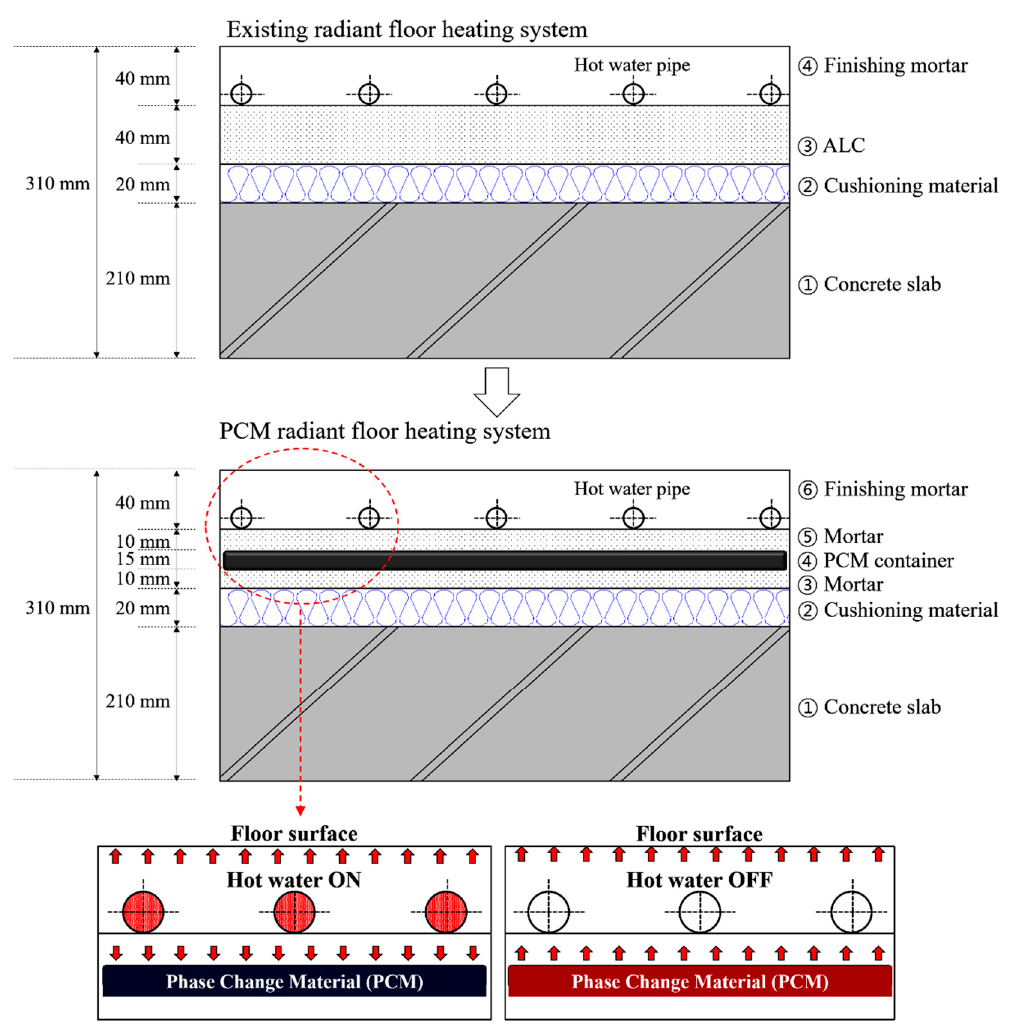
Figure 1. Comparison between existing and phase change material (PCM) radiant floor heating systems.